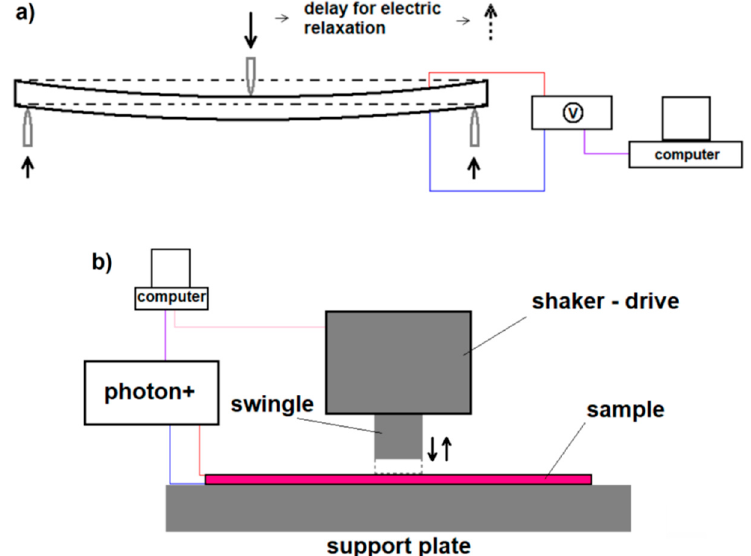
Figure 4. The scheme of: ( a ) measuring the voltage signal during static non-destructive bending of the sample; ( b ) experimental set-up of the dynamic tests with the use of a shaker.